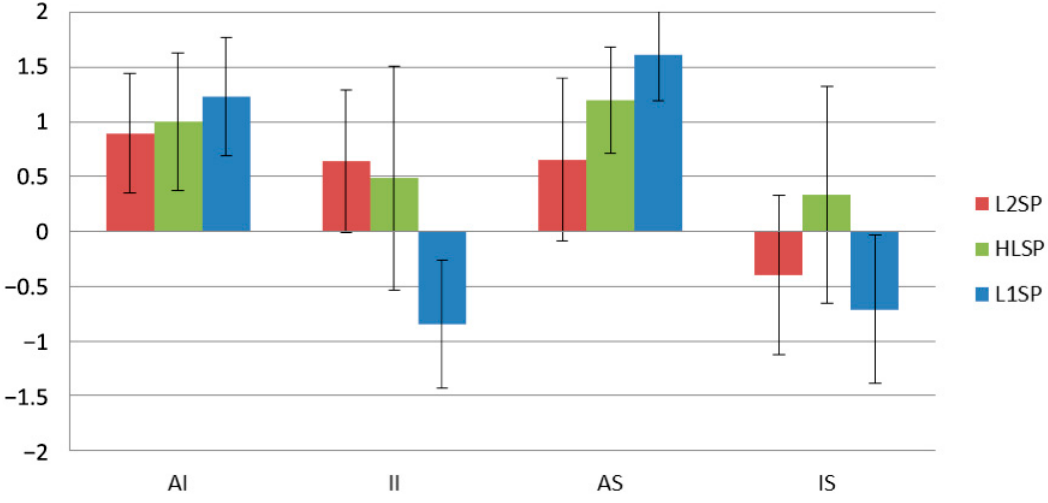
Figure 2. Overall results. Task 3—Sentence combination felicity task (oral version).